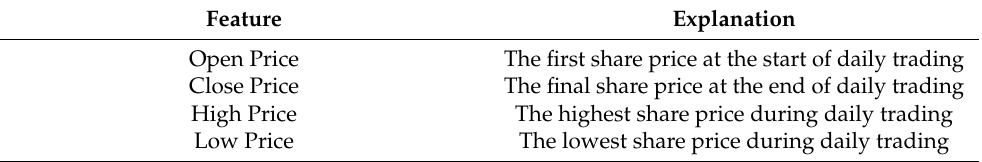
Table 1. Fundamental parameter summary.